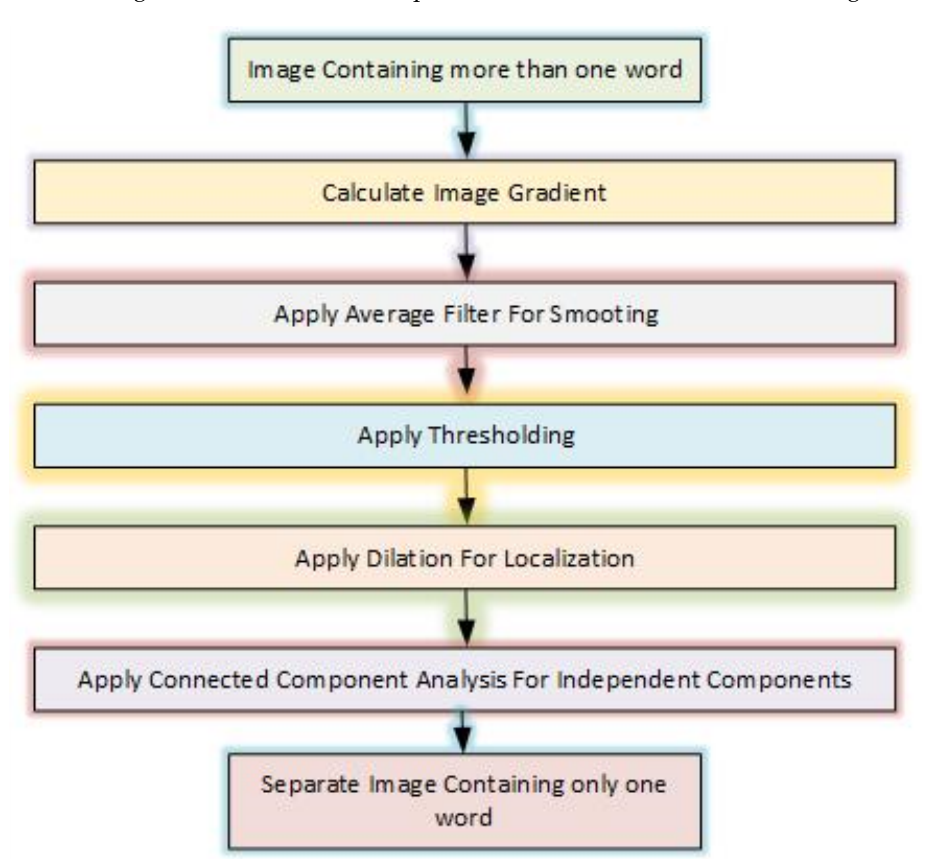
Figure 3. A flowchart of the proposed methodology used to separate words from Arabic sentence